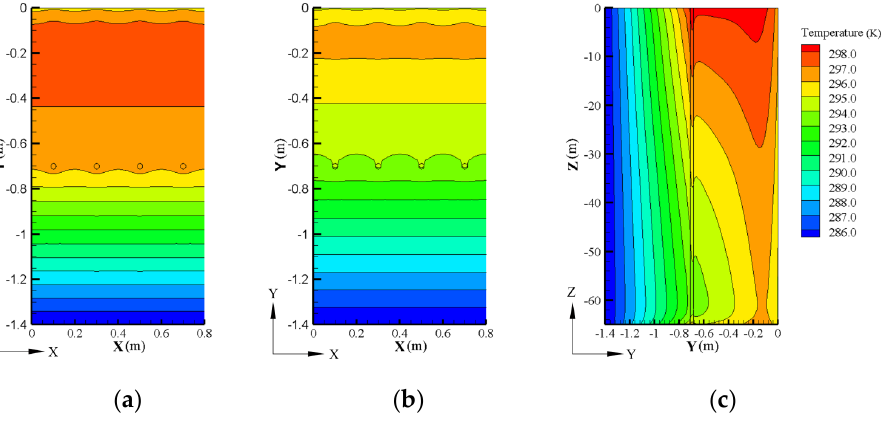
Figure 19. Soil temperature distribution at 0:00 on 8 November 2019. ( a ) Z = − 15 m, ( b ) Z = − 50 m, and ( c ) X = 0.3 m (the X-to-Y ratio is set as 20).